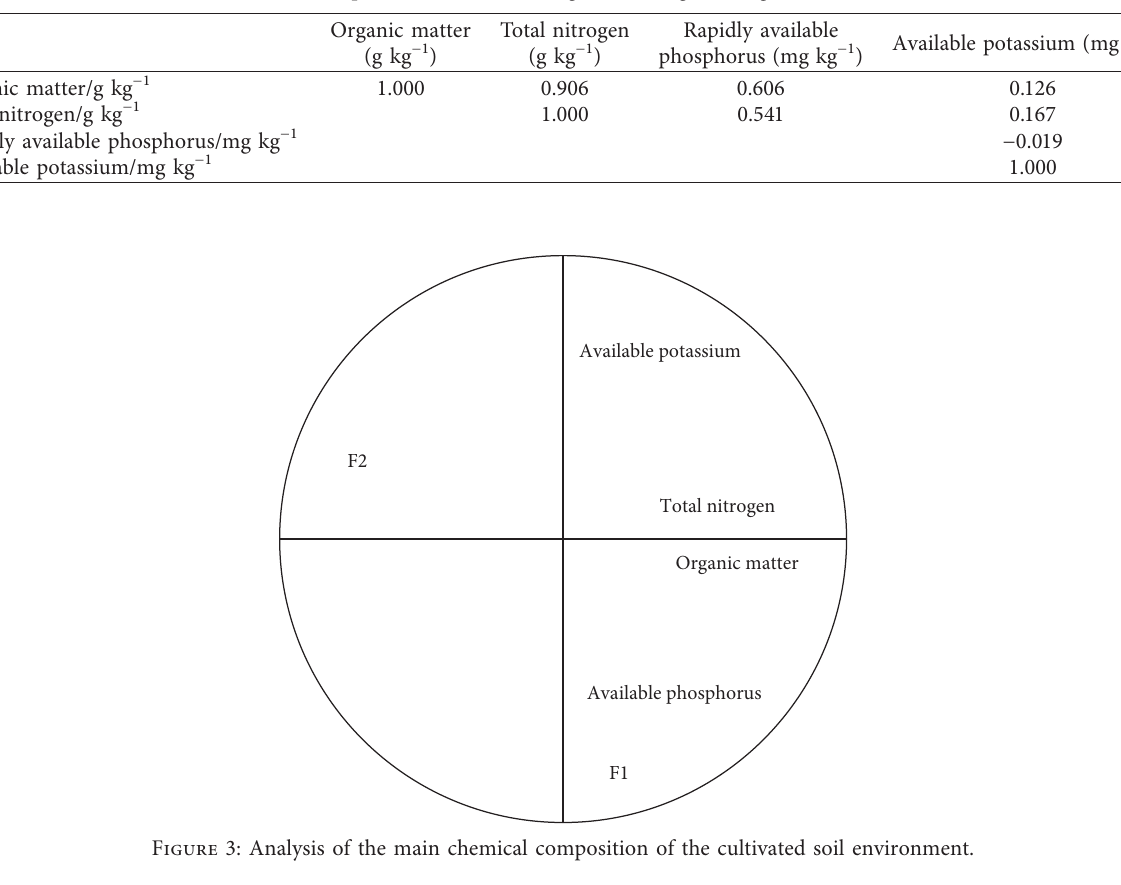
Table 1: Specific environment of greenhouse gardening fruit trees.